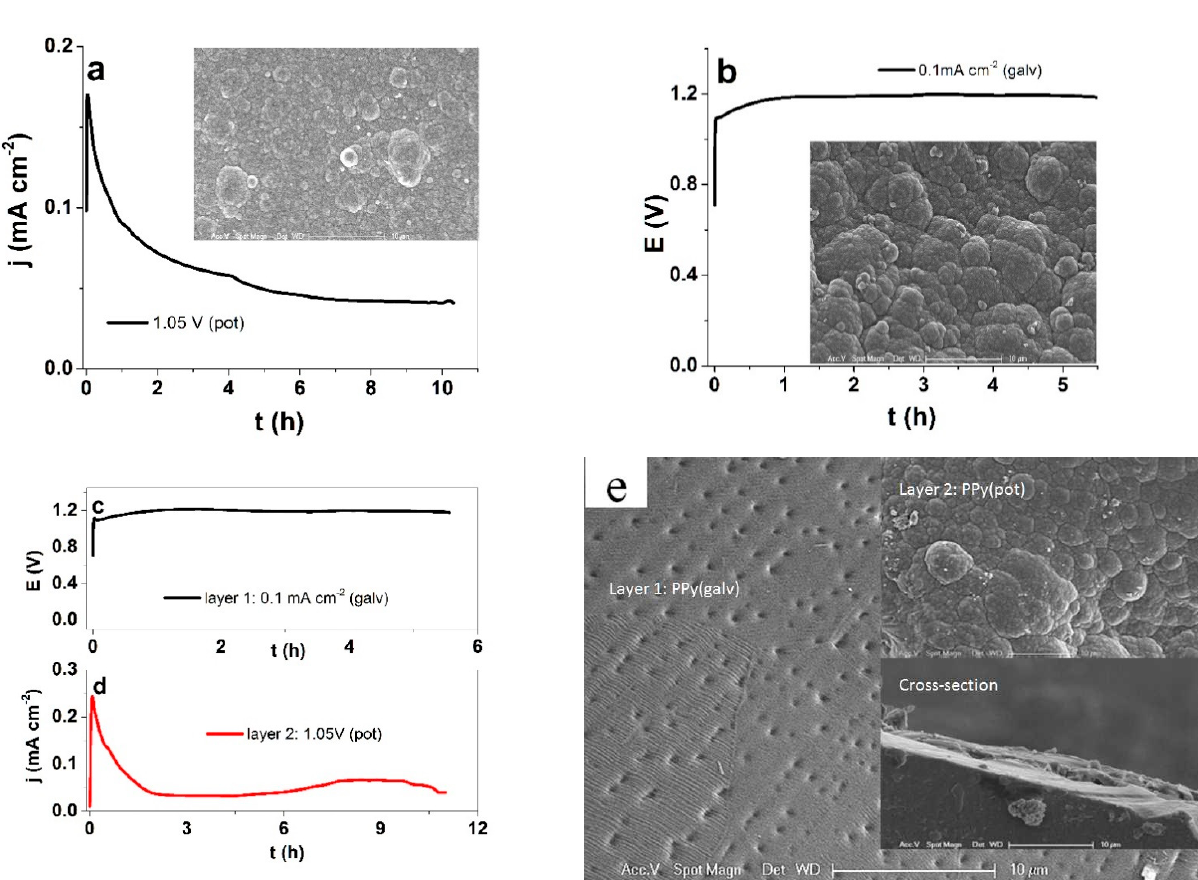
Figure 4. Electropolymerization curves and SEM surface images (scale bar 10 μ m) in ( a ) potentiostatic at 1.05 V (vs Ag/AgCl wire) and ( b ) galvanostatic at 0.1 mA cm − 2 . The electropolymerization of the PPy for BHA: ( c ) layer 1, galvanostatic (0.1 mA cm − 1 ) on stainless steel (black curve); and in ( d ) layer 2, potentiostatic (1.05 V) (red curve). The SEM surface images (scale bar 10 μ m) of BHA ( e ) PPy(galv) layer 1 with insets layer 2 (PPy(pot)) and cross-section.